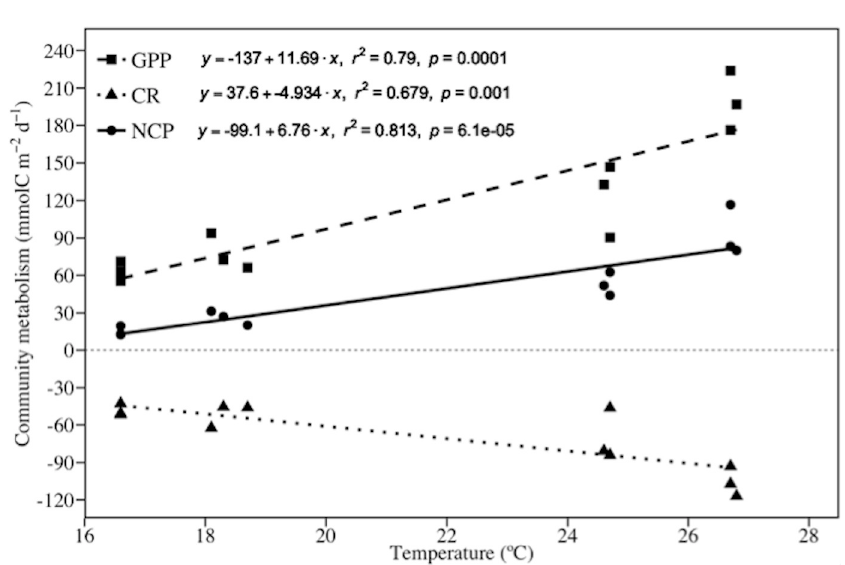
Fig 4. Relationship between carbon community metabolism and temperature on Gross Primary Production (GPP), Community Respiration (CR) and Net Community Production (NCP).